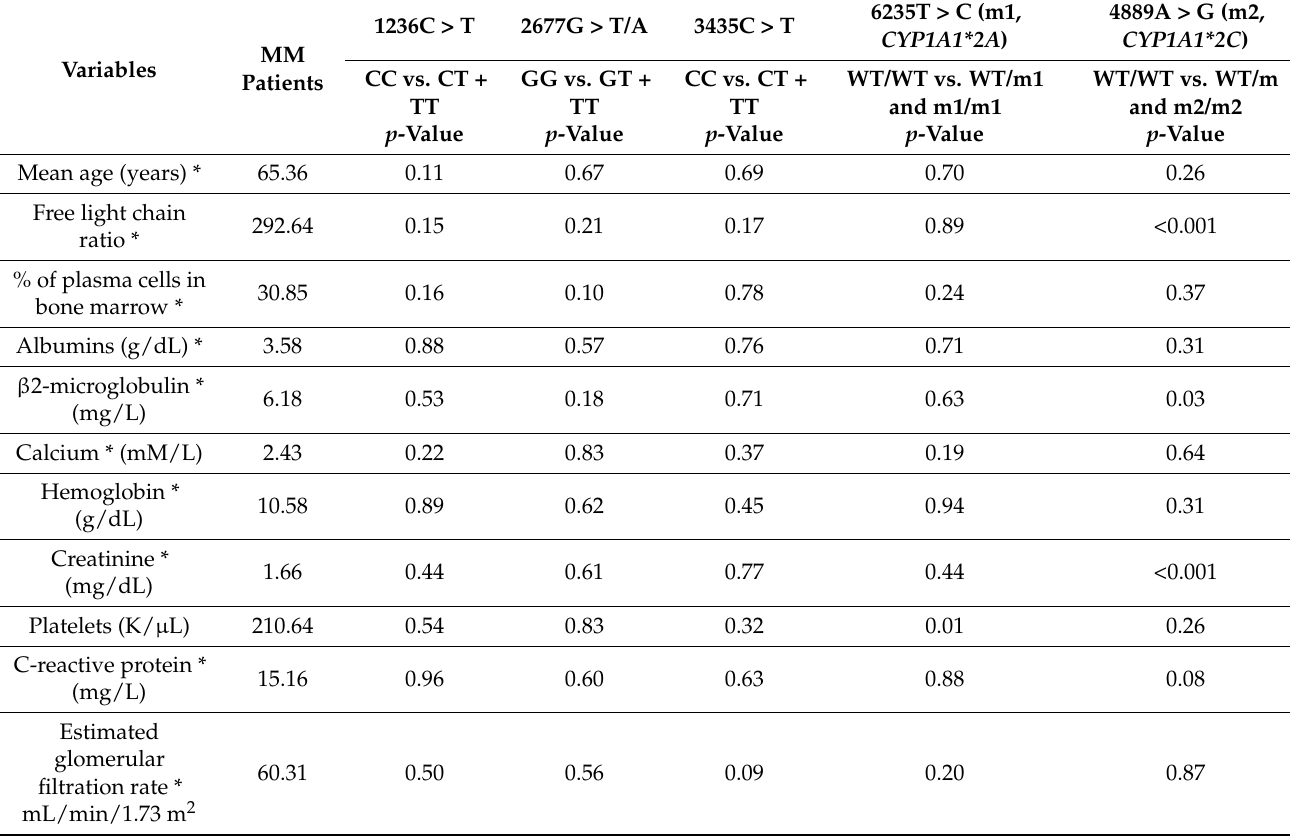
Table 6. The clinical values of MM patients included to the study taking into account studied